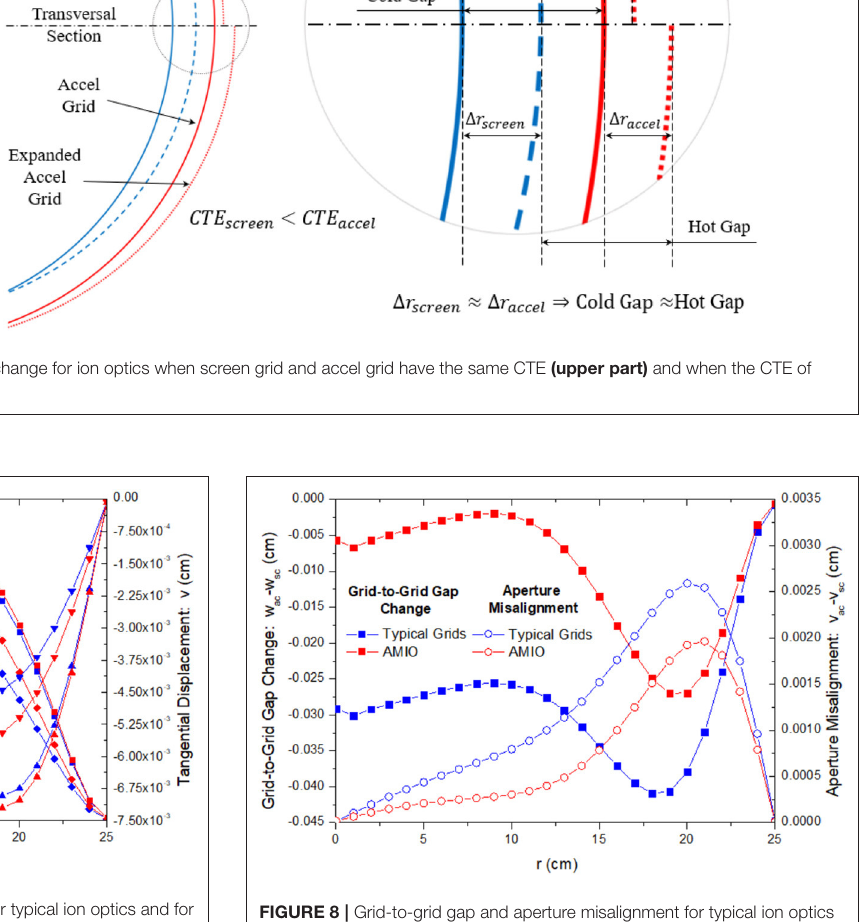
FIGURE 8 | Grid-to-grid gap and aperture misalignment for typical ion optics and for